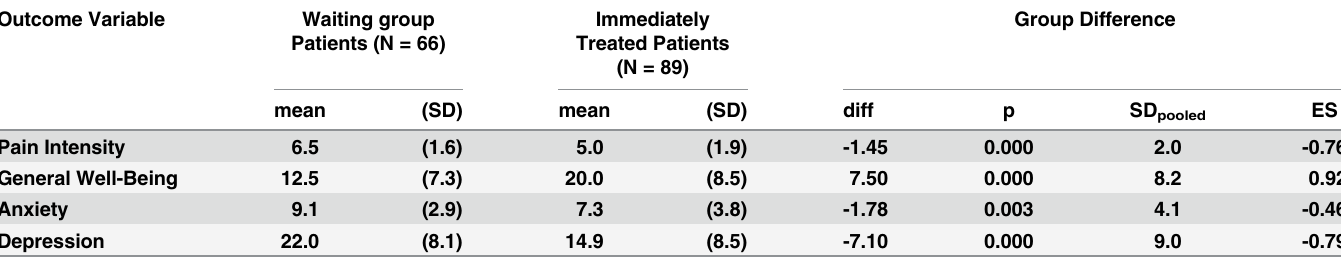
tively, were lower in the intervention group than in the control group. Table 2. Adjusted means for waiting group patients (N = 66) and immediately-treated patients (N = 89), and comparison statistics. Outcome